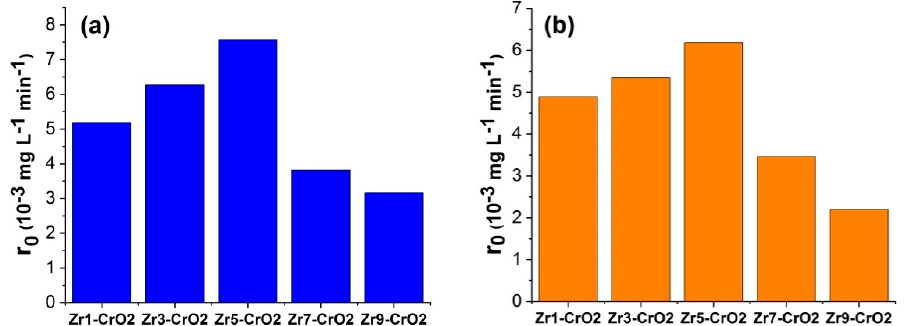
Figure 8. ( a ) Methylene blue and ( b ) Methyl orange initial rate ( 𝑟 (cid:2868) ).